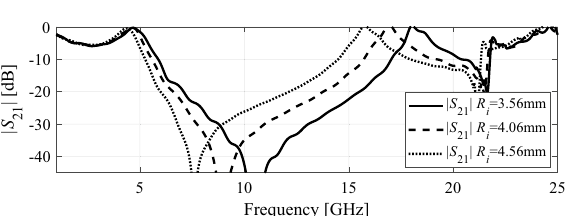
Figure 5. Comparison of transmission coefficients (|S 21 |) of the FSS unit cell for different inner radii of the outer